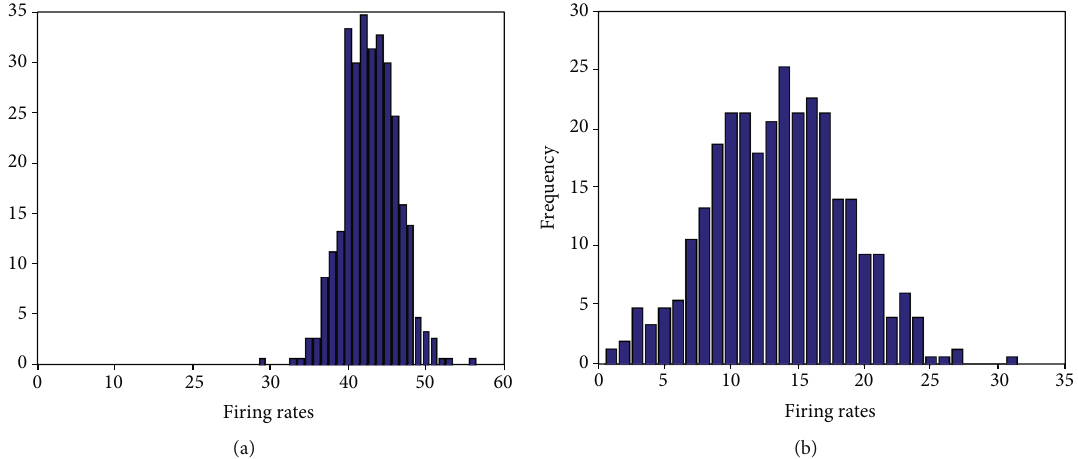
Figure 6: Firing rates of all excitatory neurons of a population of isolated excitatory neurons with noisy input to excitatory neurons, σ S (a) spiking numbers of all excitatory neurons within 300ms; (b) visualization of the fi ring rates of neurons 1-400.